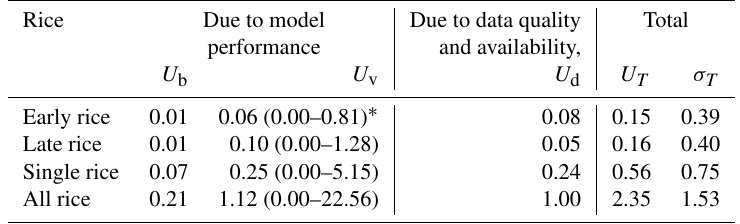
Table 4. Components of the uncertainty in the national inventory. Rice Due to model Due to data quality Total performance and availability, U b U v U d U T σ T Early rice 0.01 0.06 (0.00–0.81) ∗ 0.01 Single rice ∗ Numbers in parentheses represent the range of U v depending on the spatial correlation of the model simulation residuals. Long-distance correlation results in a large aggregated U v , whereas short-distance correlation results in a small aggregated U v